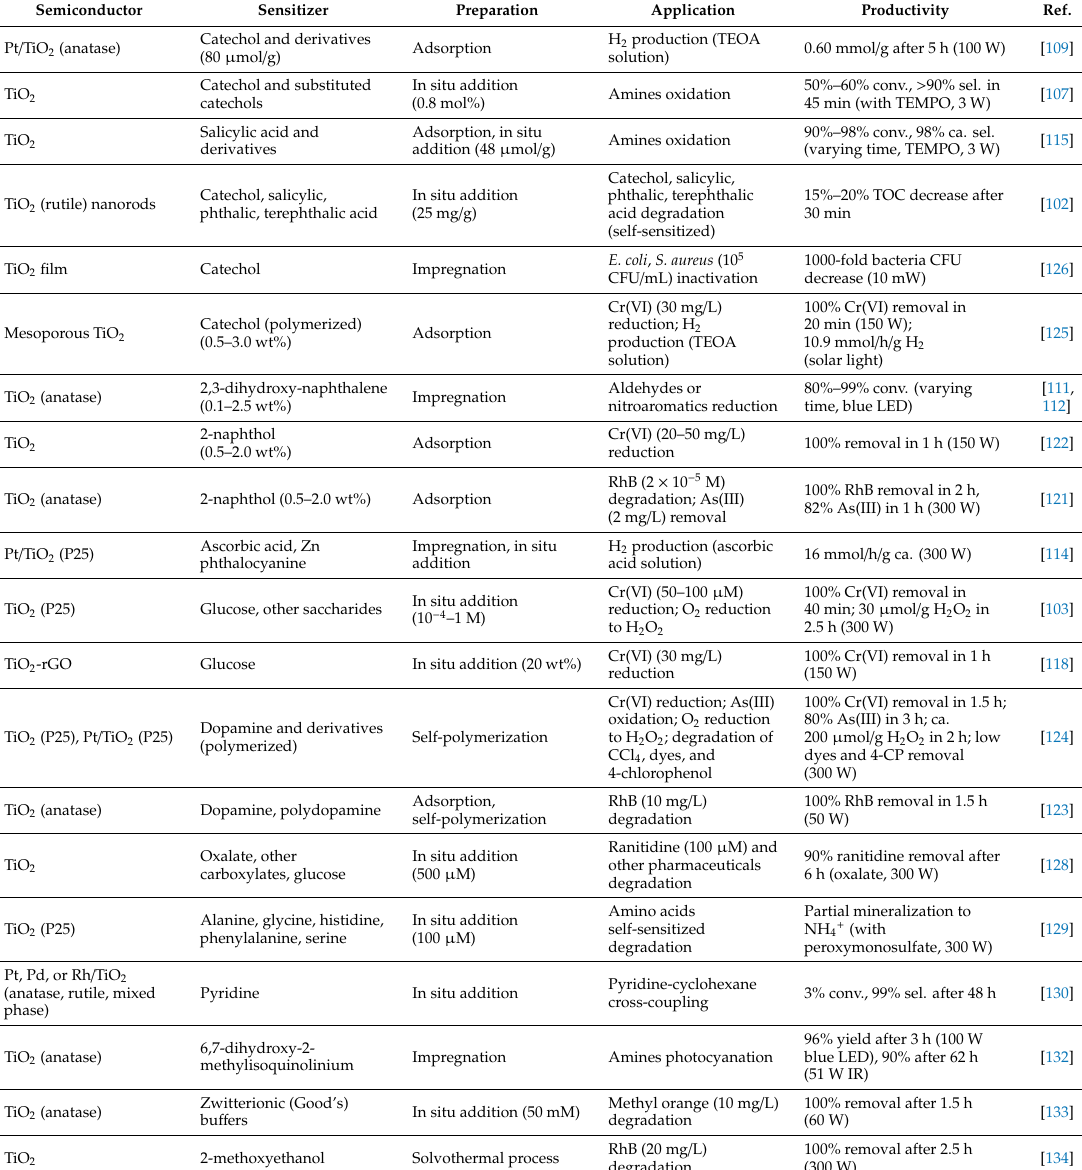
Table 3. Systems sensitized by ligand-to-metal charge transfer (LMCT) complexes and their photocatalytic activity data under visible irradiation or solar light irradiation. The best results achieved in each work are